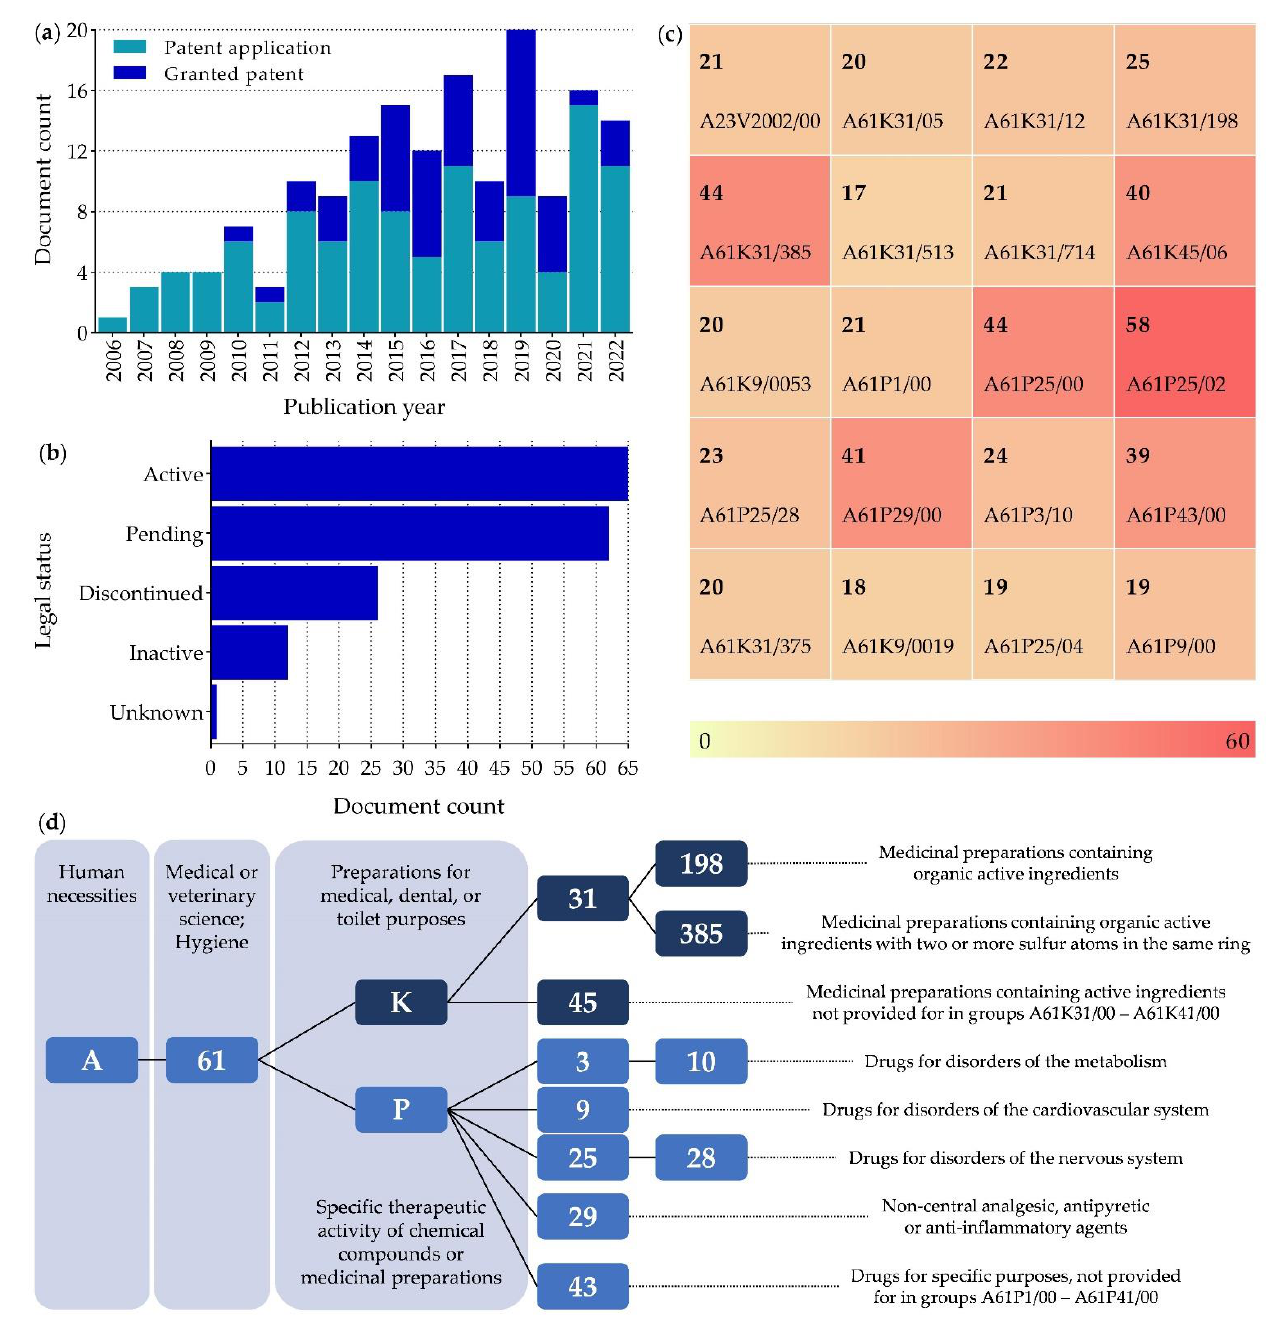
Figure 3. Summary of patent data on “alpha lipoic acid”, “neuropathic pain”, and “oxidative stress”.